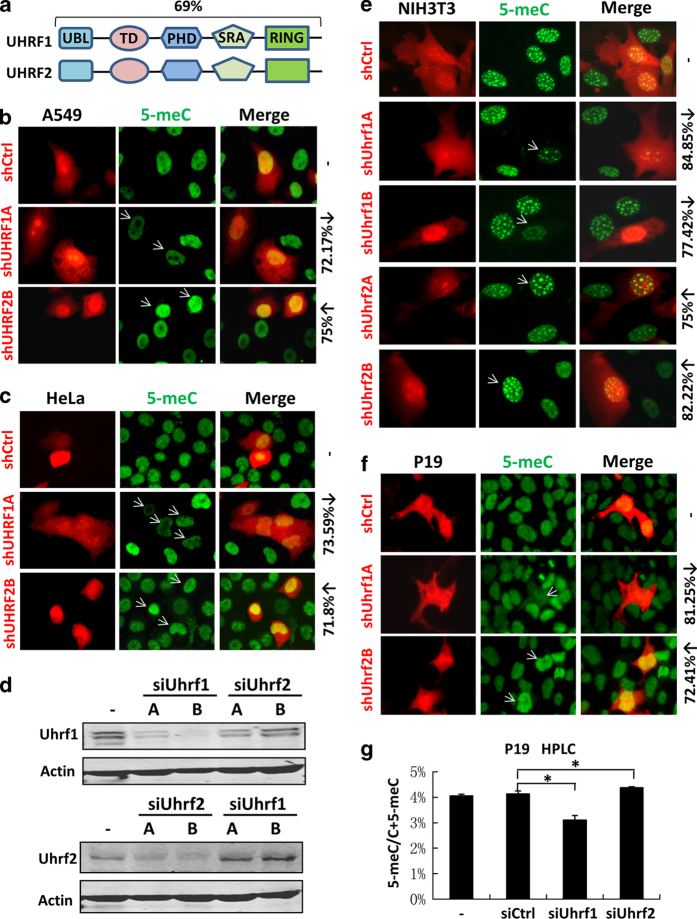
UHRF2 negatively regulates DNA methylation in both human and mouse cells. (a) Diagram illustrating the structural organization of human UHRF1 and UHRF2. PHD, plant homeodomain; RING, really interesting new gene domain; SRA, SET and ring-associated domain; TD, tandem TUDOR domain; UBL, ubiquitin-like domain. (b, c) Immunostaining analysis of 5-meC upon knockdown of UHRF1 or UHRF2 in A549 cells (b) and HeLa cells (c). Also shown is the percentage of cells with reduced (↓) DNA methylation in shUHRF1-transfected cells or increased (↑) DNA methylation in shUHRF2-transfected cells. The same labeling applied to immunostaining data in other figures. The shRNA vector was tagged with RFP. (d) Western blot analysis showing specific knockdown of Uhrf1 or Uhrf2 in P19 cells by siRNAs. (e, f) Immunostaining analysis of 5-meC upon knockdown of Uhrf1 or Uhrf2 in mouse NIH3T3 fibroblast cells (e) and P19 embryonic carcinoma cells (f). (g) Quantitative measurement of the levels of 5-meC in genomic DNA from P19 cells treated without or with control siRNA, siUhrf1 and siUhrf2. Asterisk indicates a P-value of <0.05.